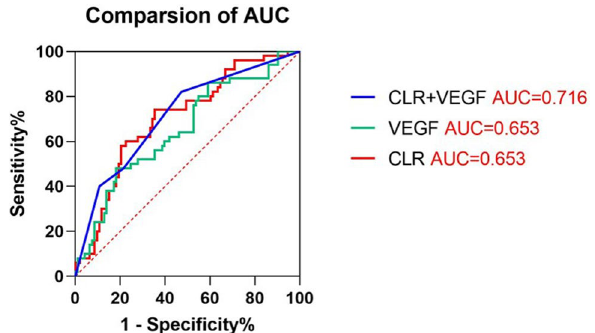
Figure 4. Comparison of the AUCs for the clinical response assessment of combined detection of VEGF and CLR (AUC = 0.716, p < 0.0001), VEGF (AUC = 0.653, p = 0.003), CLR (AUC = 0.703, p < 0.0001) at the end of radiotherapy for ESCC patients. The red entries represent statistically